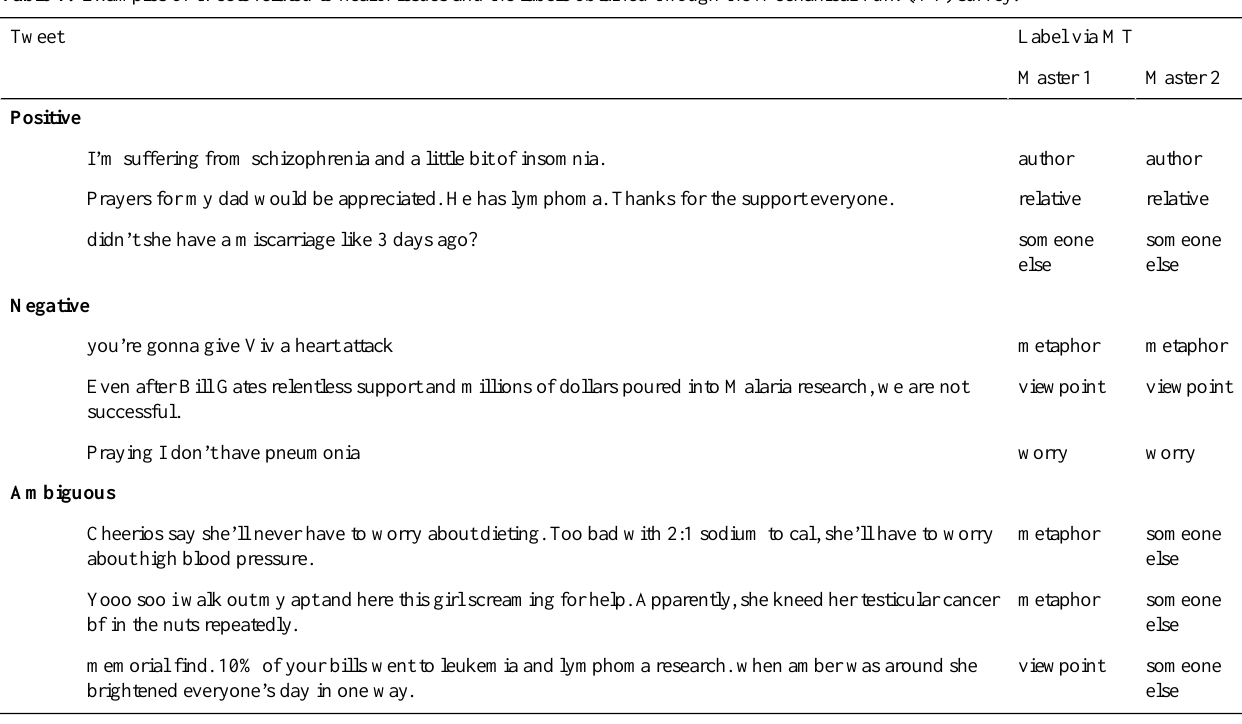
Table 1. Examples of tweets related to health issues and the labels obtained through the Mechanical Turk (MT) survey.